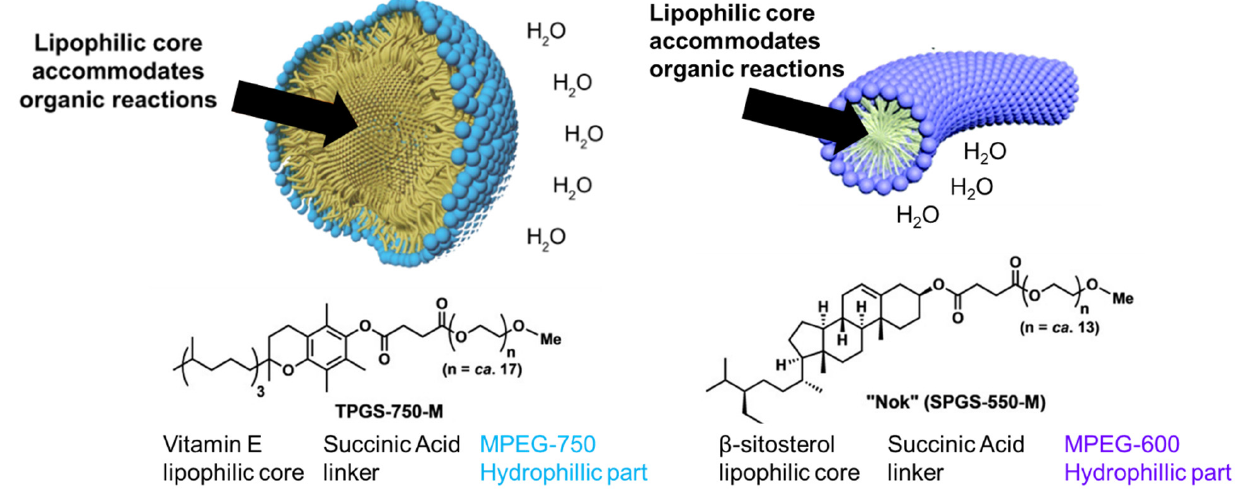
Figure 1. Schematics of self-assembled micelles from amphiphilic molecules for organic reactions. The designer amphiphilic surfactant TPGS-750-M self-assembles into spherical micelles dispersed in water. The hydrophobic core (composed of vitamin E) accommodates organic reactions using water as the bulk solvent. The designer amphiphilic surfactant “Nok” self-assembles into cylindrical structures (rod-like micelles) dispersed in water. The hydrophobic core (composed of β -sitosterol) accommodates reactions using water as the bulk solvent. Adapted with permission from [11,12].